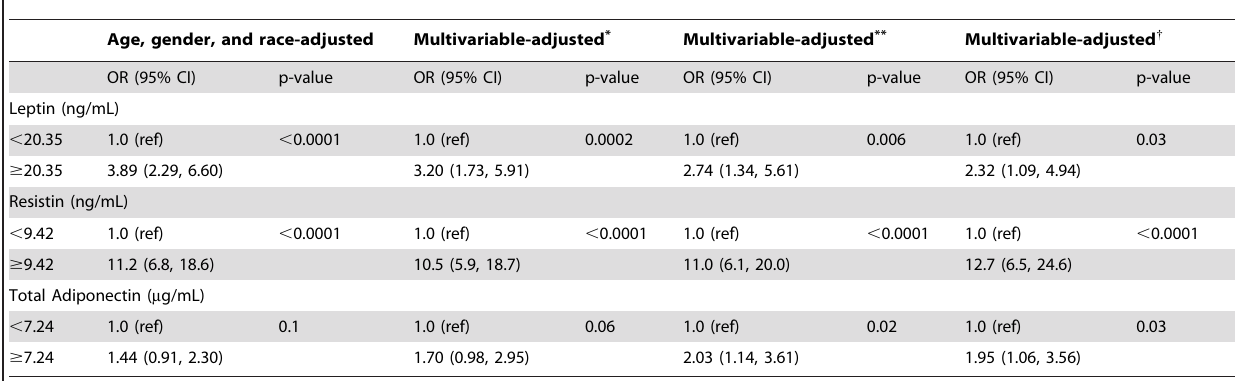
Table 3. Odds ratios of chronic kidney disease associated with highest tertile compared to the lowest two tertiles adipocytokines.